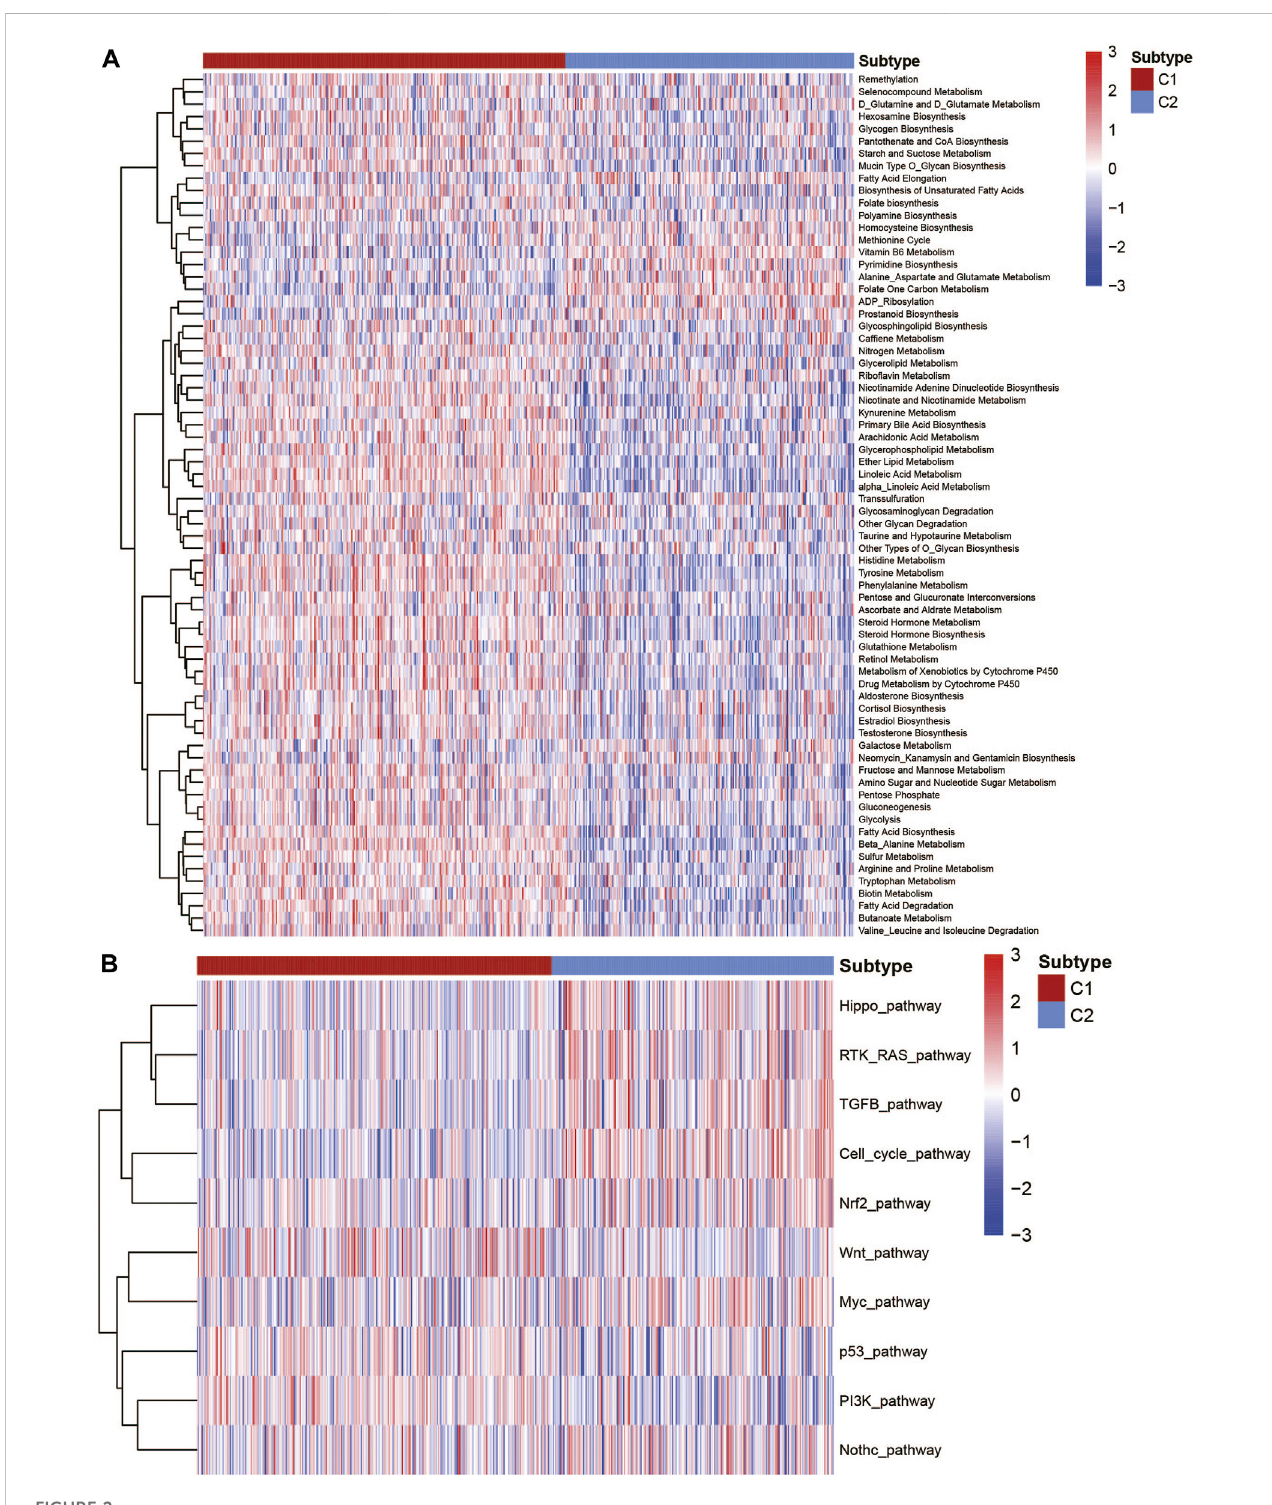
FIGURE 2 Association with the metabolism and cancer-associated pathways among UCEC metabolic subtypes. (A) Heatmap of the metabolic signatures of the UCEC metabolic subtype. (B) Heatmap of the cancer-associated signatures of the UCEC metabolic subtype.